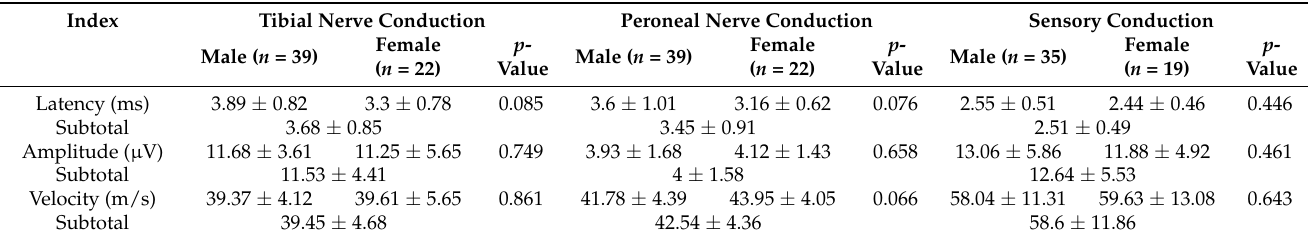
Table 4. Mean values of the motor/the sensory conduction parameters of the tibial nerve and the peroneal nerve by gender.